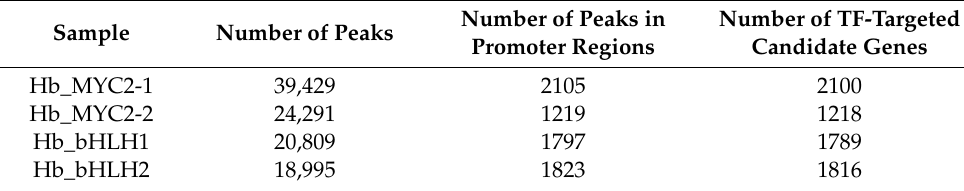
Figure 4. Identification of candidate genes targeted by four bHLH TFs using gDB-seq analysis. ( A ) Promoter regions are defined as being in the range 500 nt upstream to 200 nt downstream of the 5’ ends of genes. Genes, the promoters of which possess one or more binding sites, were selected as candidate genes targeted by the TFs. ( B ) and ( C ) Venn diagrams for the overlaps between candidate genes of Hb_MYC2-1 and Hb_MYC2-2 (B), and Hb_bHLH1 and Hb_bHLH2 ( C ). Table 2. Summary of gDB-seq analysis.